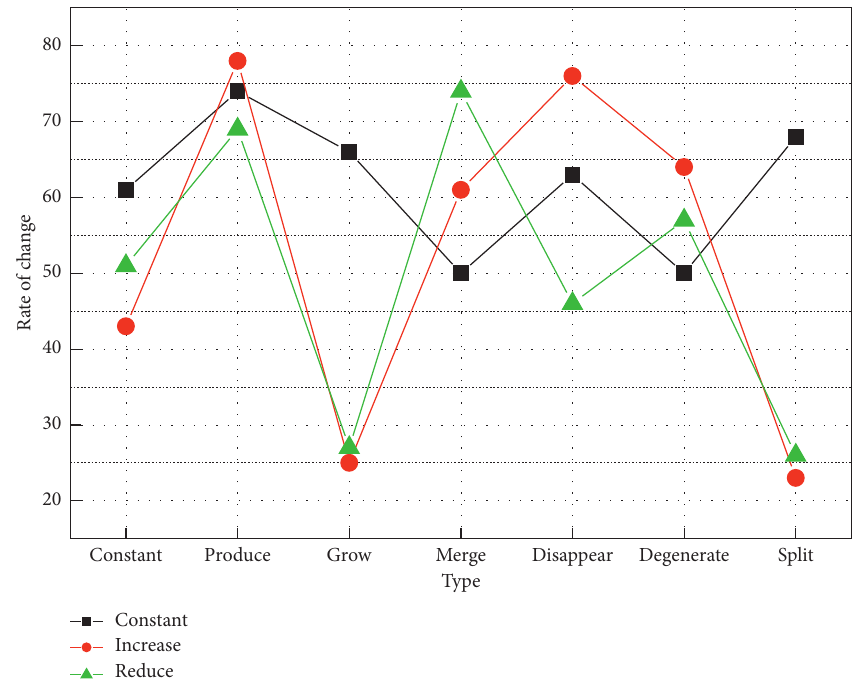
Figure 7: Statistical chart of the percentage of urban development in each geographical type zone.